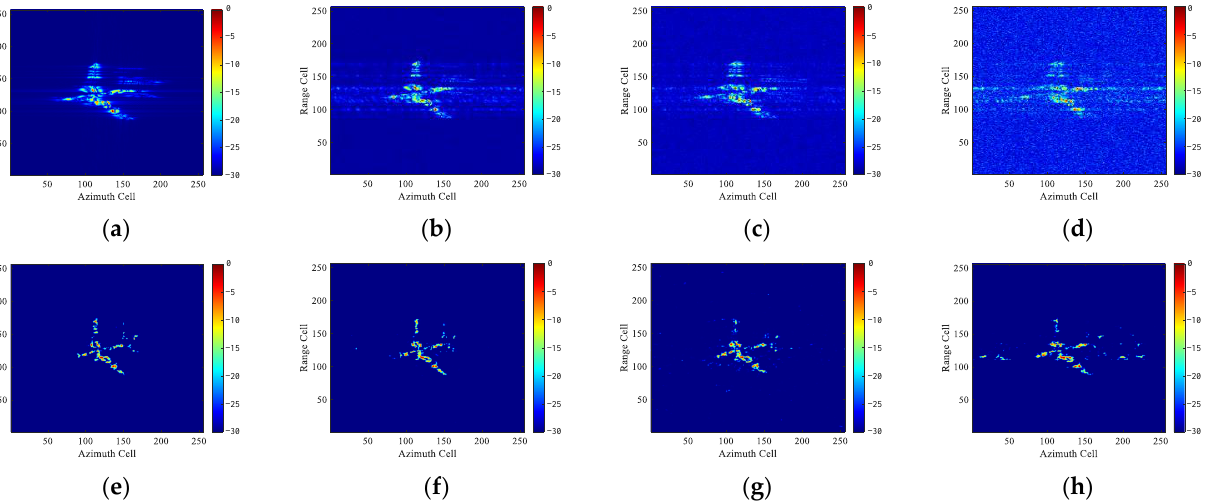
Figure 17. Imaging results of the block target with the motion parameters and imaging condition as listed in Table 2: ( a – d ) Imaging results by RD method; ( e – h ) Imaging results be the proposed method.